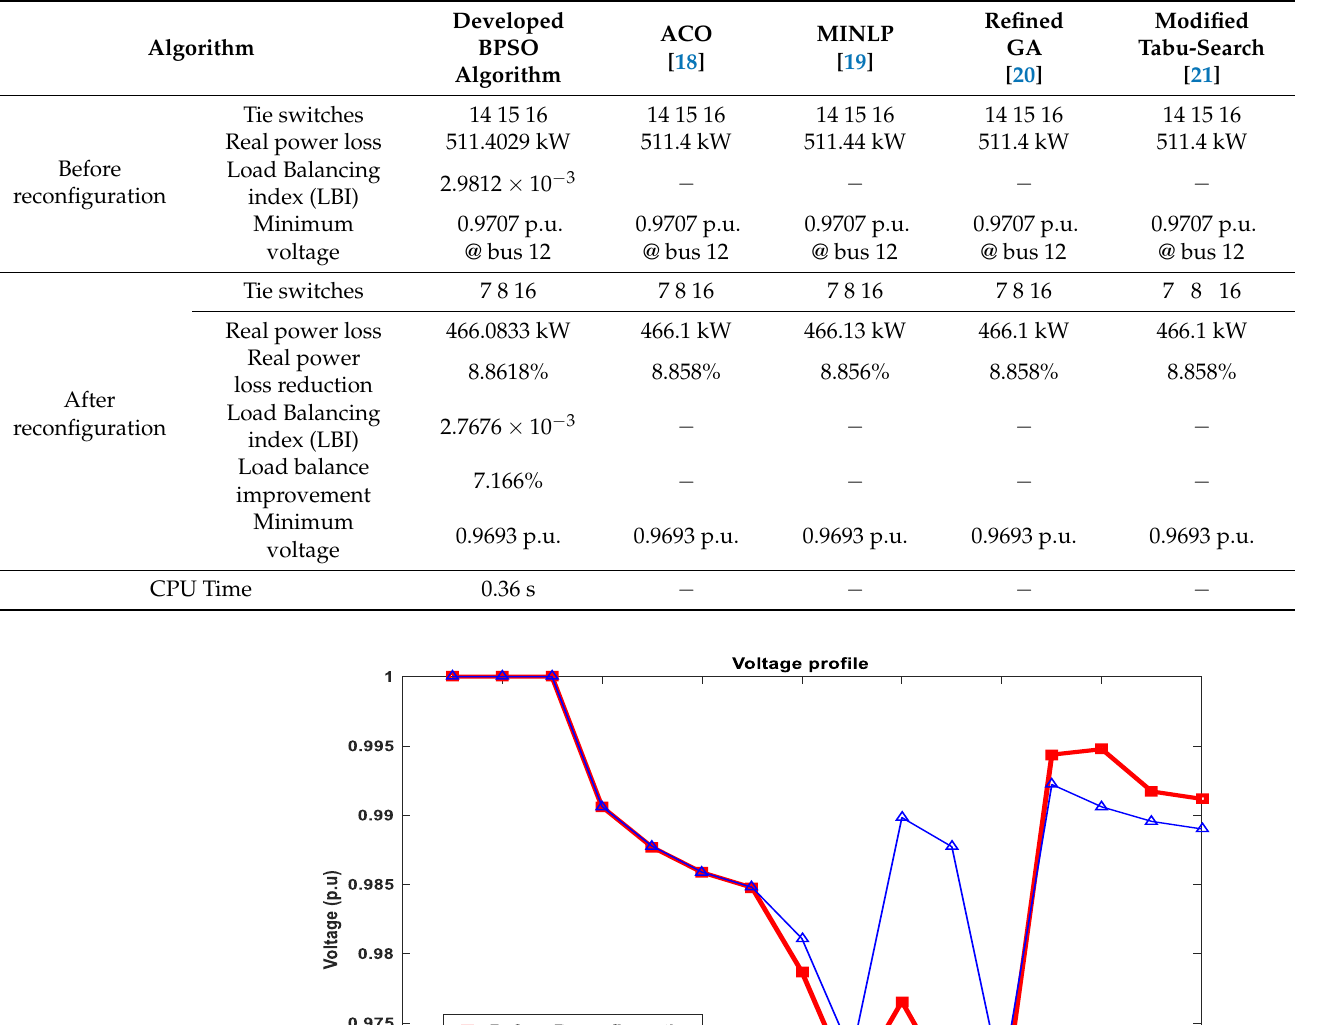
Table 2. The simulation results of the 16-bus distribution system.